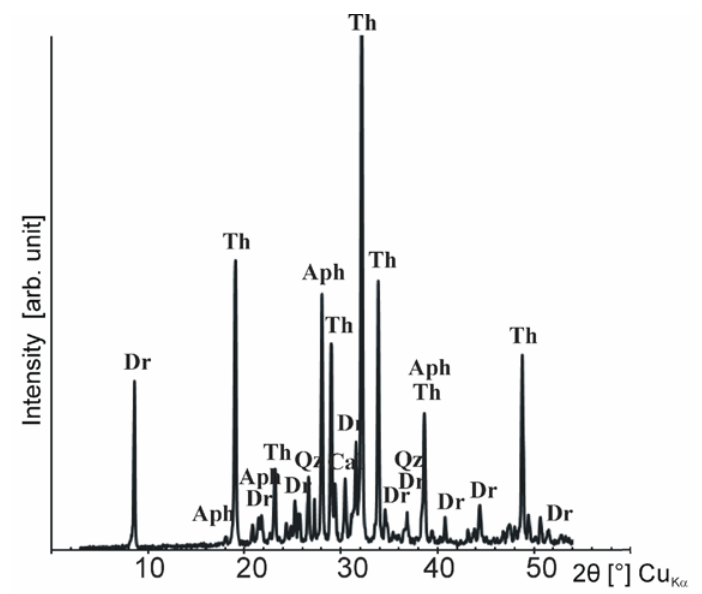
Figure 13. Characteristic X-ray patterns of the efflorescence sampled from the border between the subwall limestone blocks and cement mortar. Abbreviations: Aph—aphthitalite, Cal—calcite, Dr—darapskite, Th—thenardite, Qz—quartz.